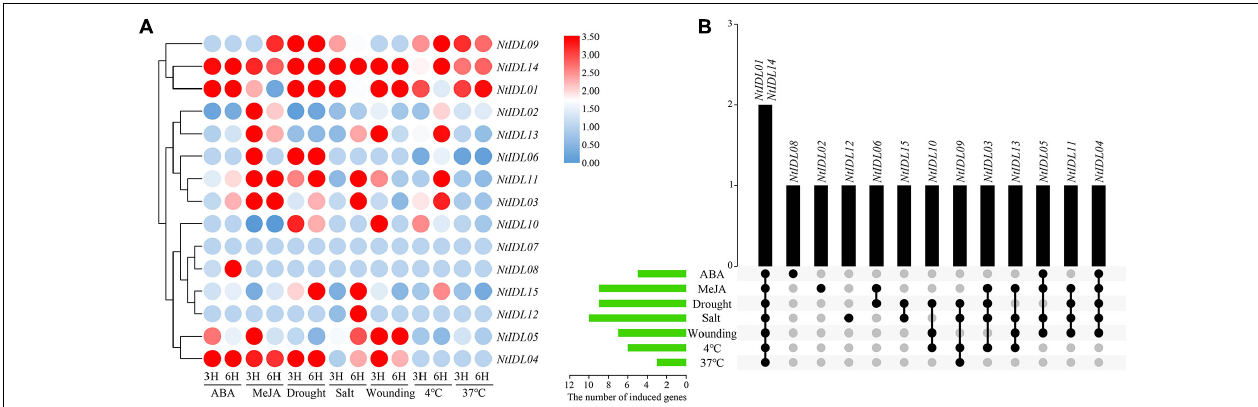
FIGURE 5 | The expression patterns of NtIDL genes in tobacco seedlings under multiple abiotic stress treatments. (A) The relative expression ratios of abiotic stress treatments, “3H” and “6H” represent 3 and 6 h after stress treatments, respectively. Expression levels were calculated through the 2 − (cid:49)(cid:49) Ct method and normalized relative to gene expression in control plants. Expression levels relative to control plants are given next to the color scale. Red, white and blue represents the induction (values over 1), invariance (values close to 1) and inhibition (values under 1) of genes related to the control treatment, respectively. (B) The summarized information of the stress-induced NtIDL genes. Black dots indicate NtIDL genes responsive to stress treatments and gray dots indicate NtIDL genes that did not respond to the stress